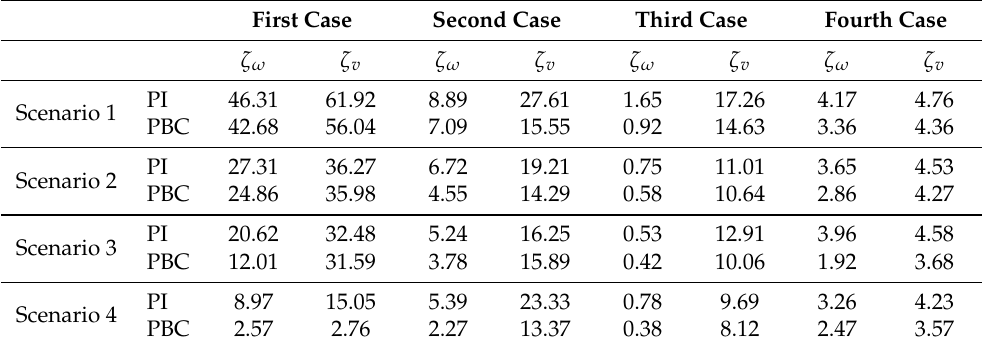
Table 3. Integral of the time-weighted absolute error for rotor speed deviations and generator terminal voltages.